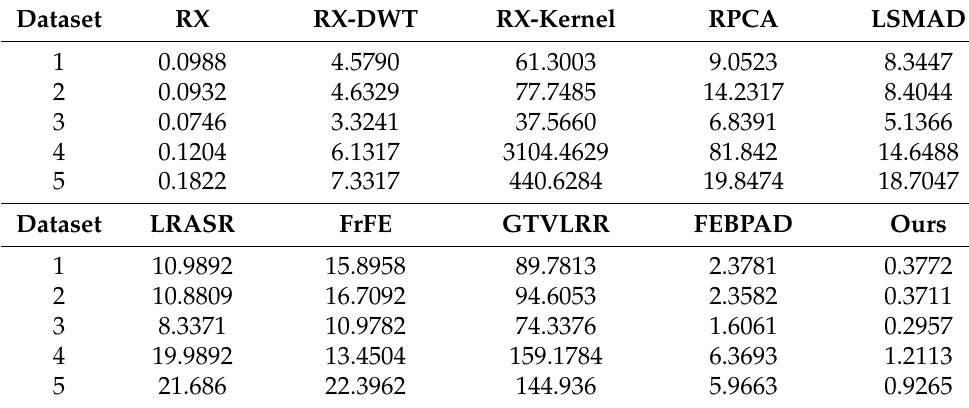
Table 5. The computation costs of different AD methods on the three datasets (in